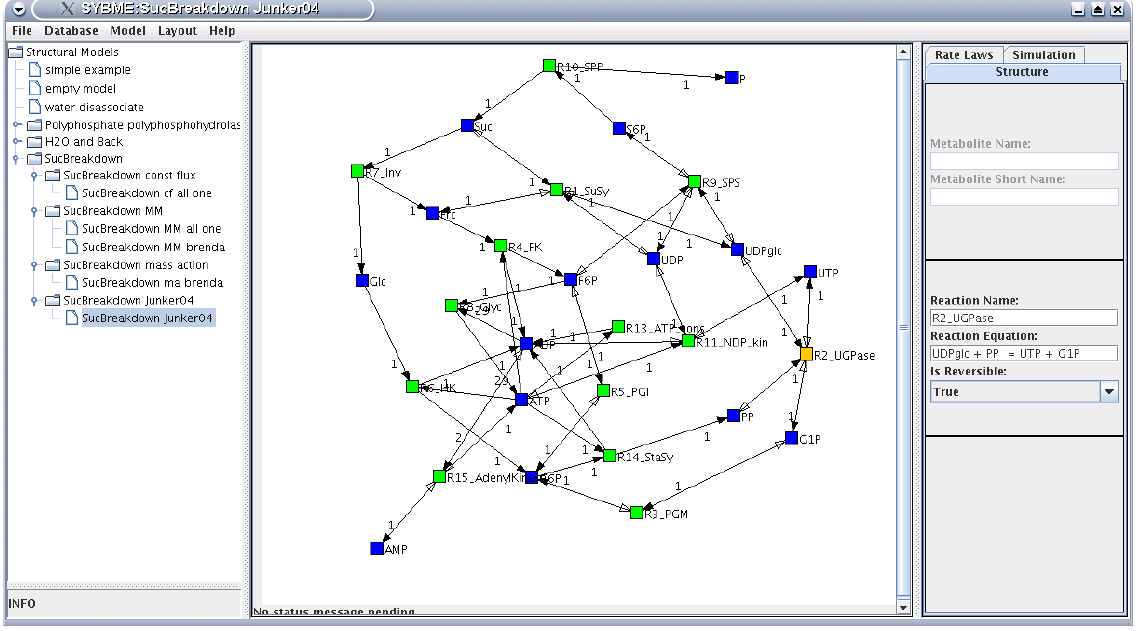
Figure 4: The SyBME graphical user interface. On the left side the hierarchy of models is visible. In the middle the active model, sucrose breakdown, is shown and on the right side the reaction equation for reaction UGPase is